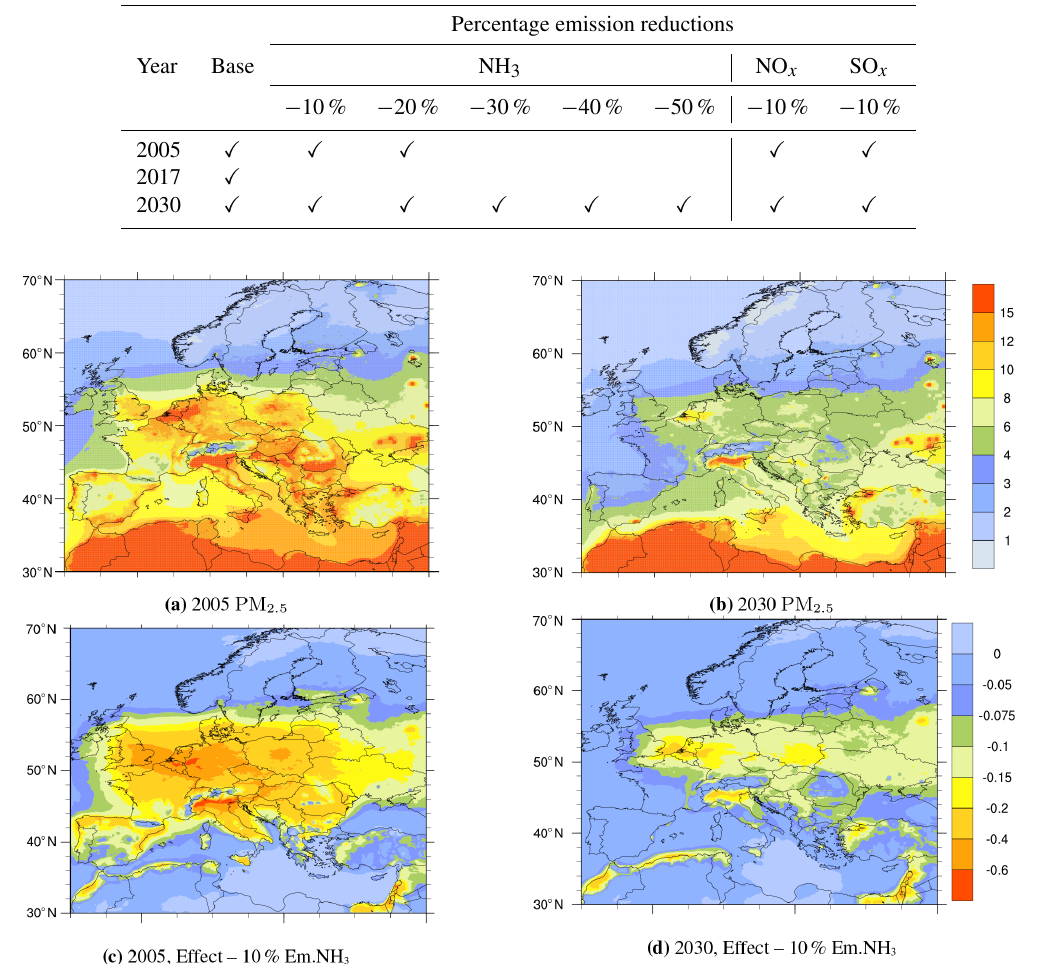
Table 2. Model runs performed. All model runs have been performed with 2017 meteorological conditions as described in Sect. 3. Base denotes model runs with all emissions for the years 2005, 2017, and 2030. For 2005, emissions in the EU28 are based on EMEP 2005 official emissions. Remaining land-based emissions from ECLIPSEv6a. For 2017 all emissions are as reported in the EMEP Status Report 1/2020 (2020) Appendix B. For 2030 EU28 emissions are scaled according to the NEC2030 obligations based on the 2005 emissions. Remaining land-based emissions from ECLIPSEv6a. Emissions and model runs are also described in Sect. 3. The additional model sensitivity runs reducing the emissions in steps of 10% are also listed.